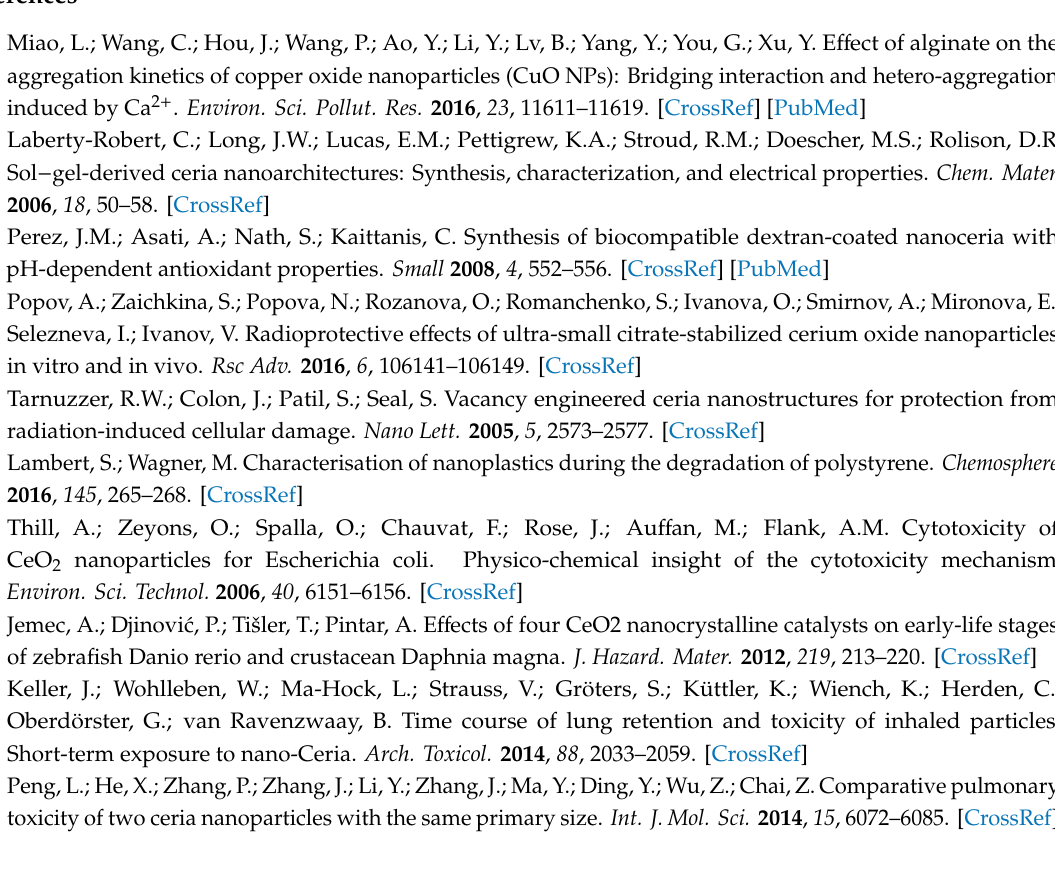
Figure S1: The magnified SEM images of the activated sludge from R4 (the yellow circles in Figure S1 a, b, c, d represent the filamentous bacteria, spherical bacteria, rod-shaped bacteria and the attached CeO 2 NPs, respectively.), Figure S2: Relative LDH release during one cycle after 1 day and 10 weeks of exposure to CeO 2 NPs at di ff erent concentrations, respectively. Error bars represent standard deviations of triplicate measurement, Figure S3: The energy spectrum of activated sludge within the two-week recovery time after relief from the 10-week exposure to 0.1 (a), 1 (b), and 10 (c) mg / L CeO 2 NPs, Figure S4: Heat-map of the four reactors within the two-week recovery time after relief from the 10-week exposure to di ff erent CeO 2 NPs